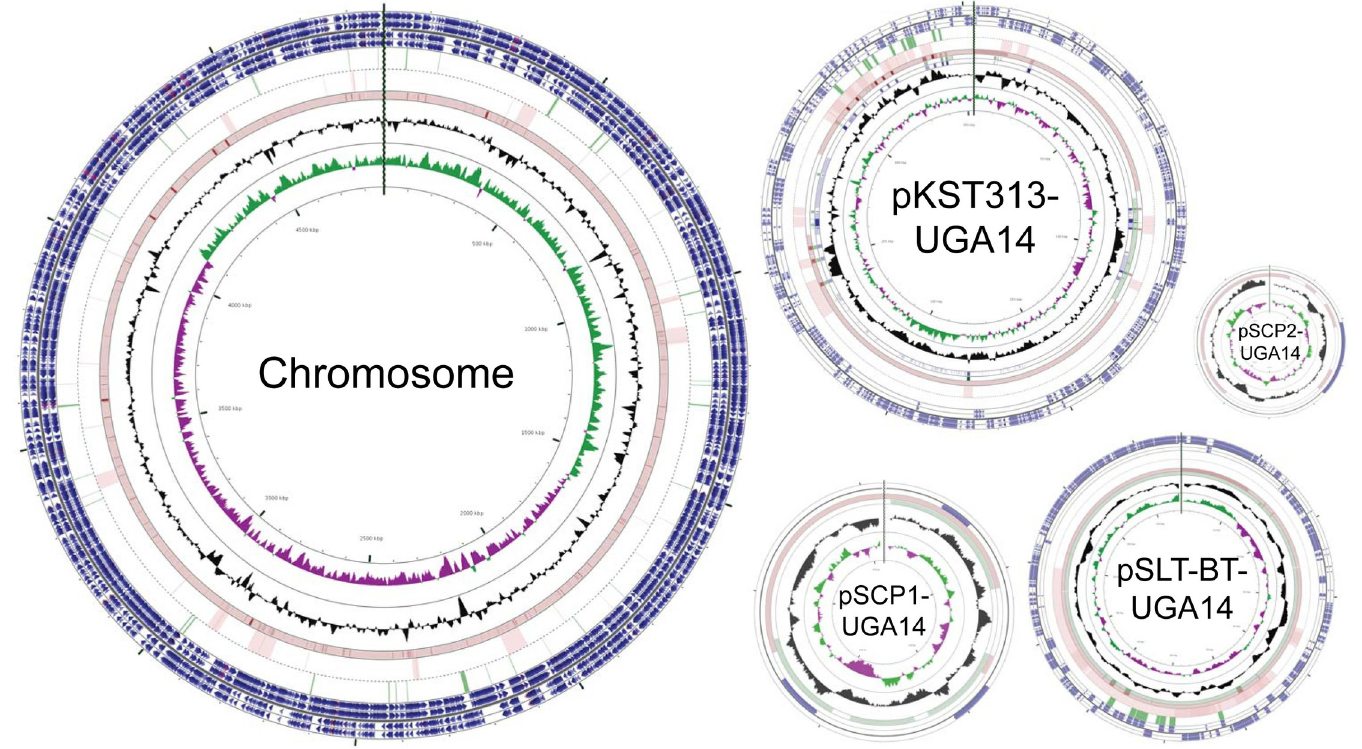
Fig 2. Circular representation of the S . Typhimurium UGA14 genome including the chromosome and four plasmids. The outermost four circles indicate start sites of genes. Starting on the outside, circles 1–2 consist of forward-strand gene products; circles 3–4 consist of reverse-strand gene products (colors represent the following categories: CDS, blue; tRNA, brown; rRNA; magenta; other, grey); circle 5 shows AMR genes; circle 6 shows mobile gene elements (insertion sequences and prophage genes); circles 7–9 show homologous regions of blastn search against near neighbors in GenBank (highly similar regions are shown in darker color); circle 8 shows GC content; circle 9 shows GC bias (G-C/G+C where green indicates values > 1 and purple < 1).